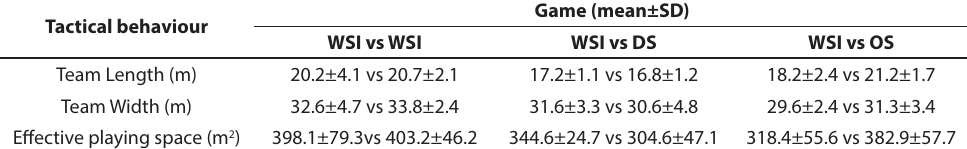
TABLE 2 Descriptive results from the comparisons among considered game scenarios for tactical variables